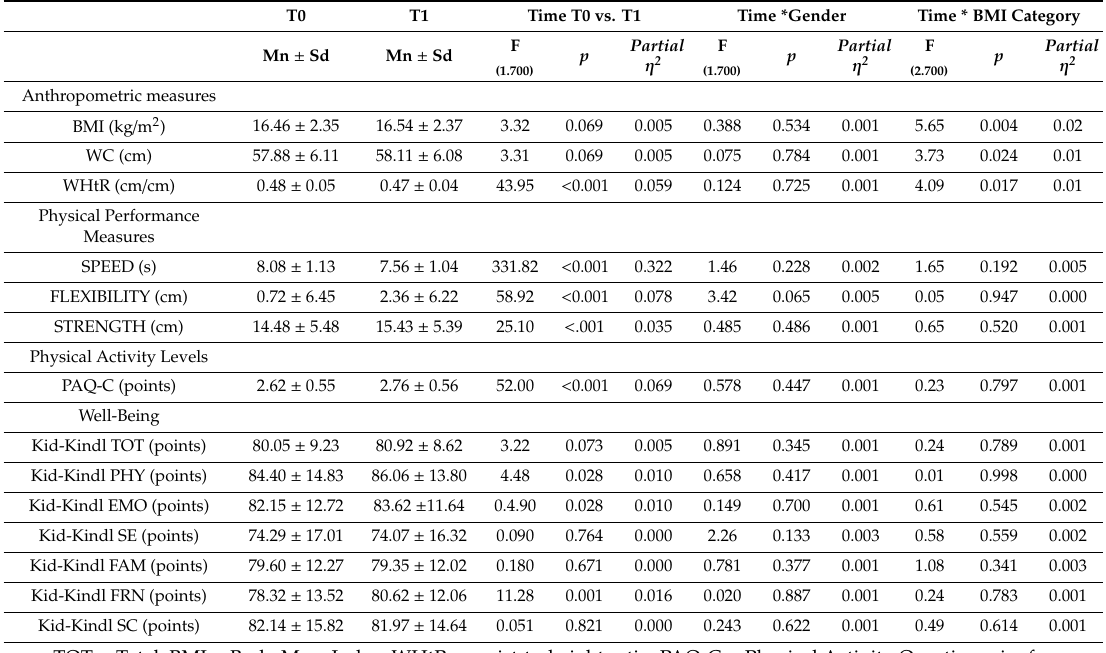
Table 2. Repeat Measure Multivariate Analysis of Variance to analyze di ff erences in all variables between T0 and